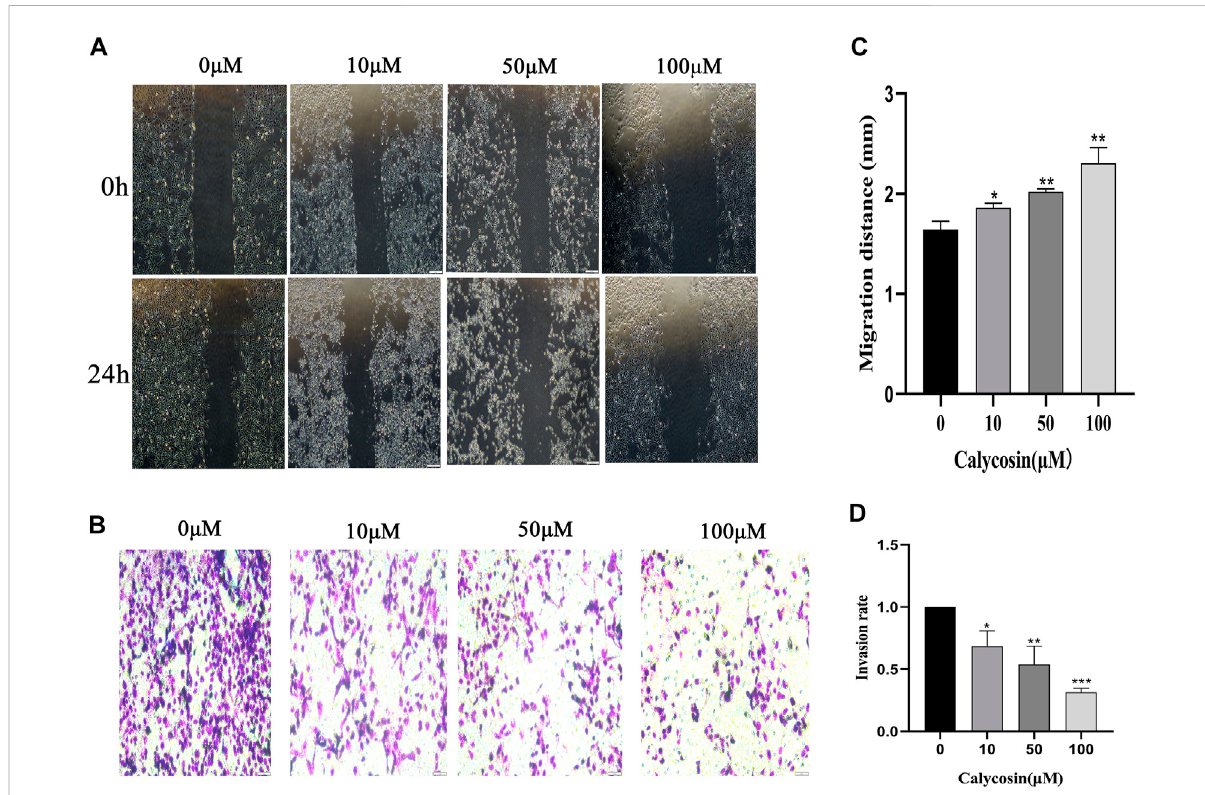
FIGURE 2 Calycosin inhibited the migration and invasion of B-CPAP cells. (A) Wound healing assay results in control or calycosin-treated B-CPAP cells at 0 and 24 h. (C) The distance between wound edges was measured. (B) Transwell invasion assay results showed the invasiveness of B-CPAP cells treated with calycosin. (D) The number of invasion cells was counted with ImageJ software. Results are representative of three independent experiments. * p < 0.05, ** p < 0.01,*** p <